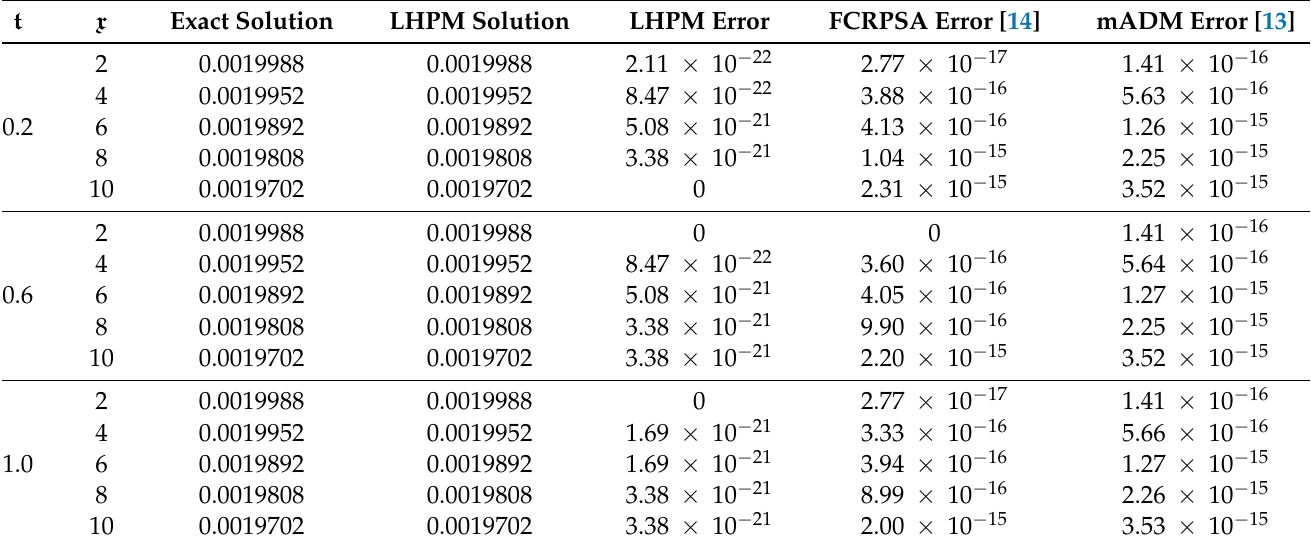
Table 5. Comparison of LHPM errors with FCRPSA and mADM in Example 2 when β = 1 and k = 0.01.